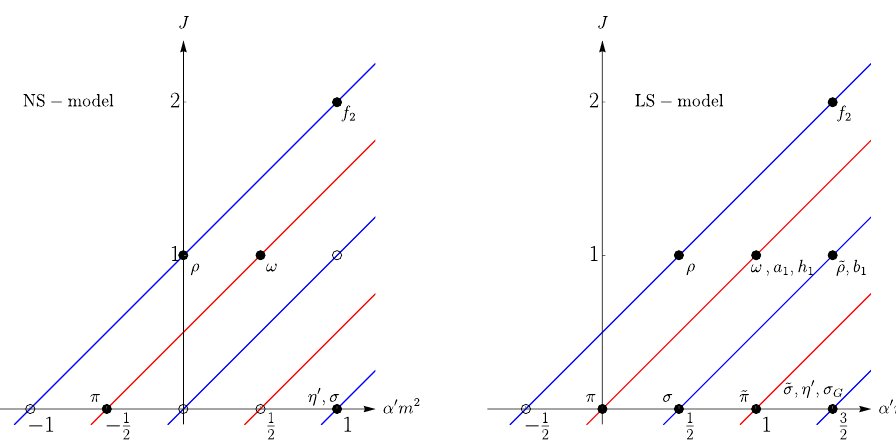
Figure 1 . Spectrum of NS (left) and LS (right) model in four dimensions, Regge trajectories in blue (red) have G-parity +1 ( − 1 ). Bullets represent ‘physical’ states, open circles represent ‘missing’